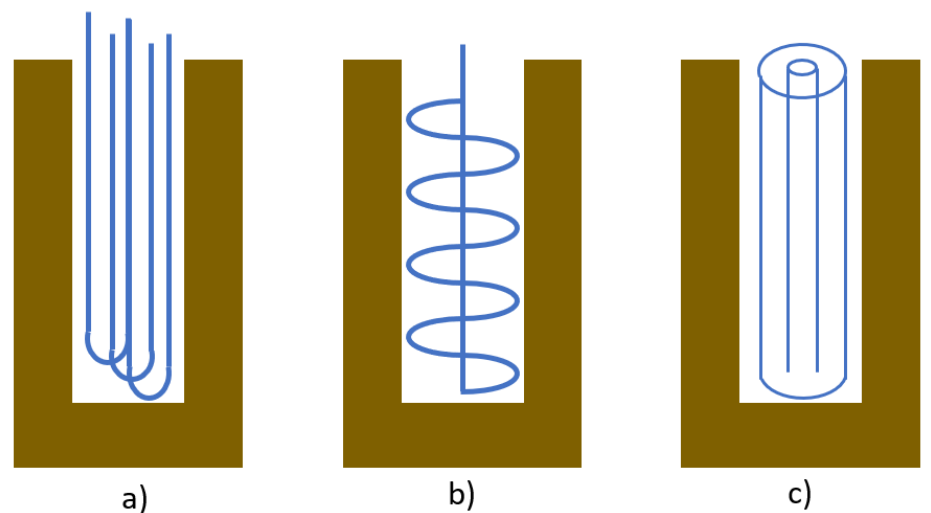
Figure 7. BHE enhanced configurations: ( a ) Multi U-tube, ( b ) Helical, ( c ) Coaxial.